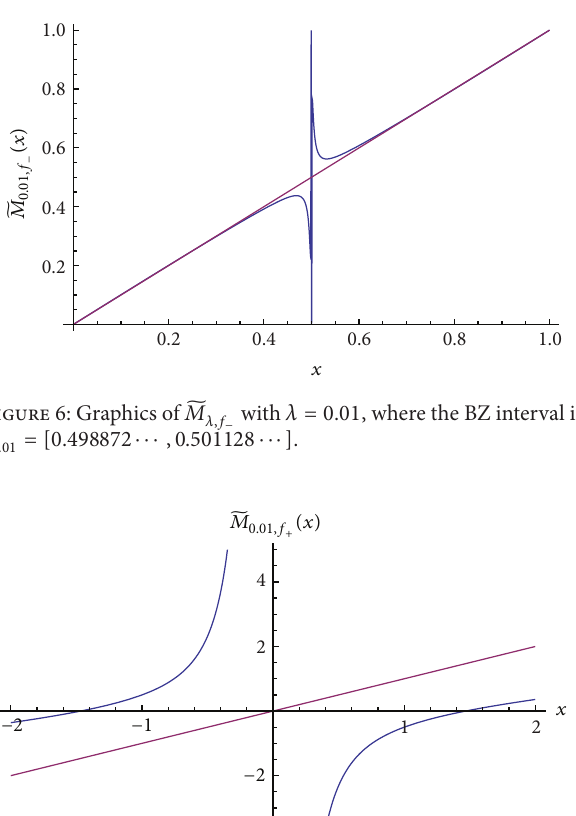
Figure 6: Graphics of 𝐼